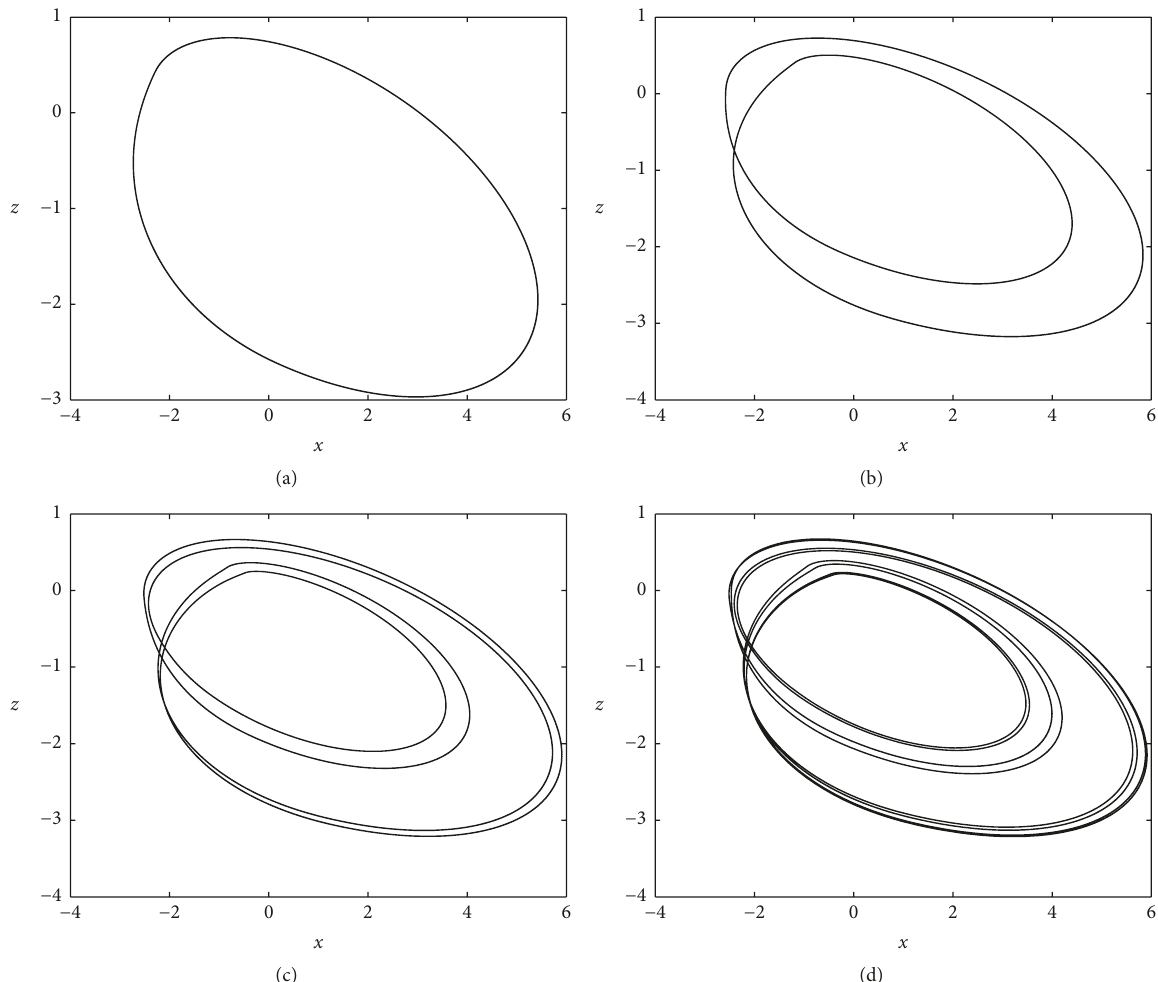
Figure 3: Different periodical dynamics observed in 𝑥 - 𝑧 plane for 𝑏 = 4 and 𝑐 = 1 ; initial conditions (𝑥(0),𝑦(0),𝑧(0)) = (0, 0,0) when (a) 𝑎 = 5.75 , (b) 𝑎 = 6.25 , (c) 𝑎 = 6.625 , and (d) 𝑎 = 6.665